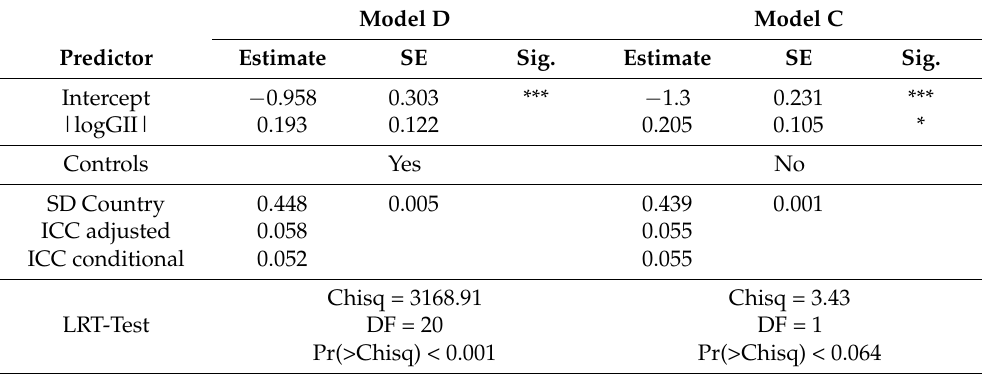
Table 5. Multilevel logistic models of effect of GII on the probability of emotional Isolation (SNI emo <